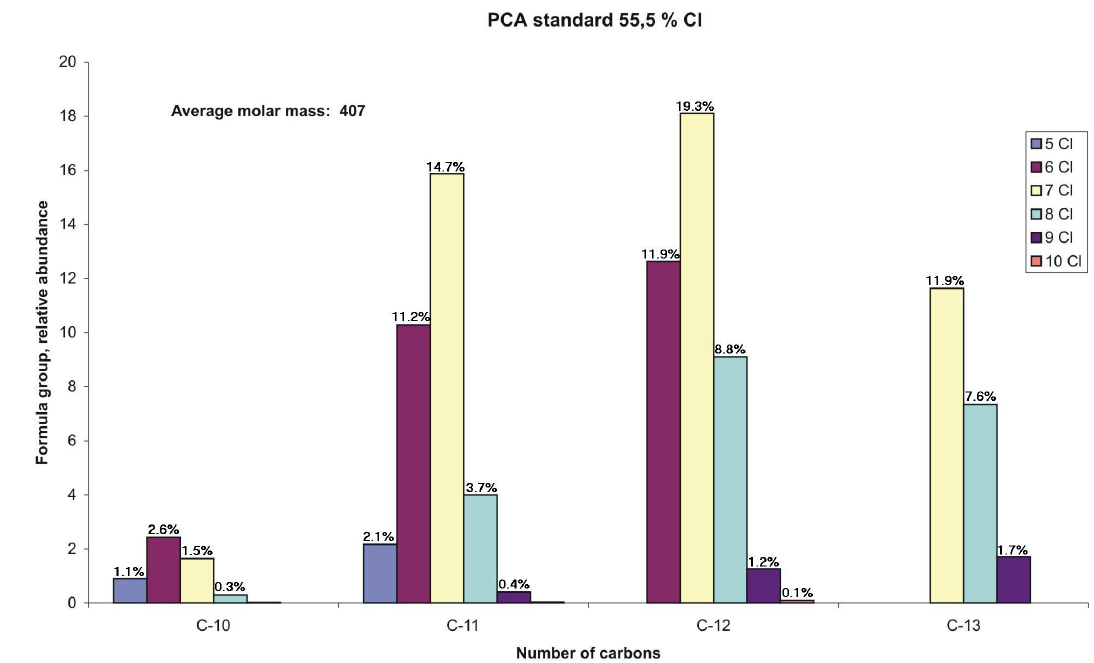
FIGURE 2. sPCA pattern in a technical mixture containing 55.5% Cl used as a quantification